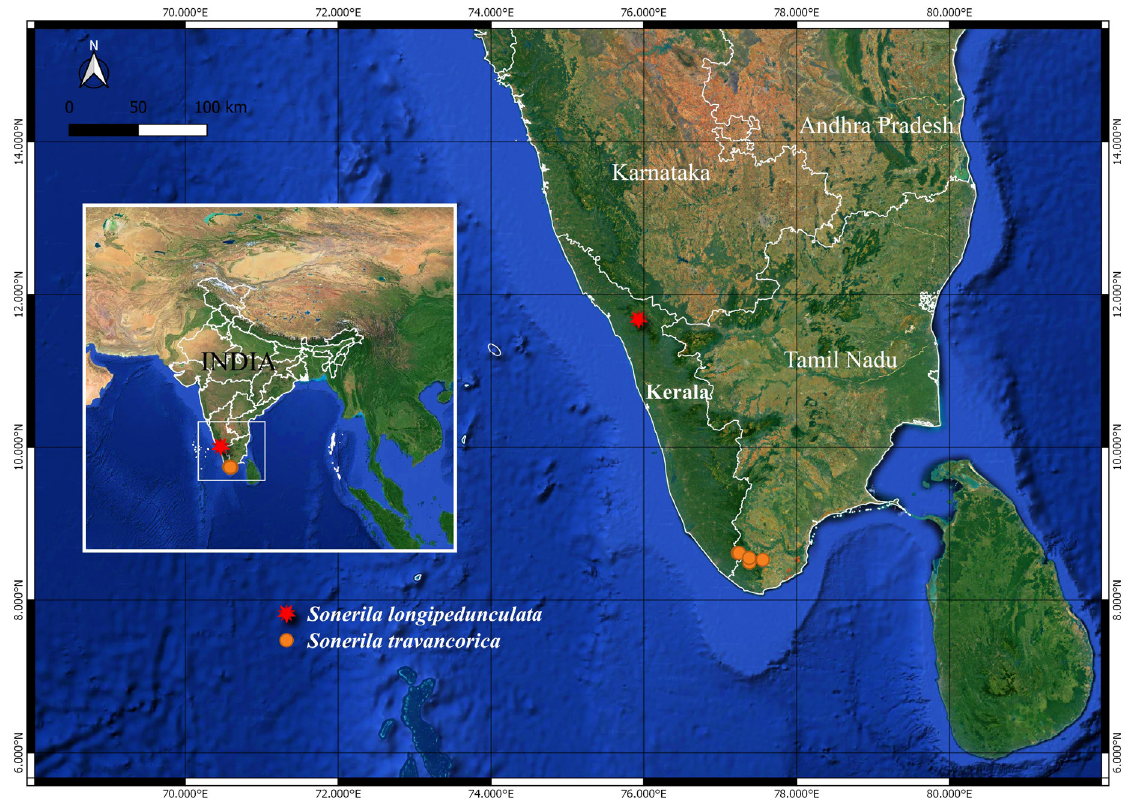
Fig. 1. Map showing the distribution of Sonerila longipedunculata Resmi & Nampy sp. nov. and S. travancorica Bedd.; prepared by Resmi S. using QGIS ver. 3.12.2 (QGIS